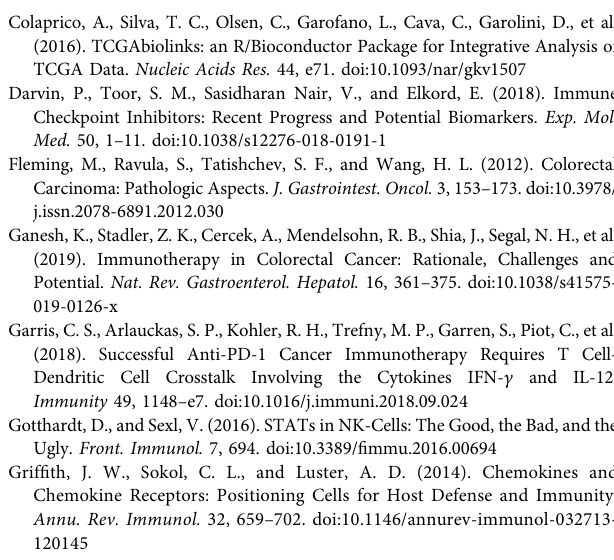
Supplementary Figure S1 | Results of the computation/exclusivity analysis of the top20mutatedgenesintheICI-treatedcohort(Samsteinetal.,2019)(A)andTCGA- COAD (B) cohort. Supplementary Table S1| ResultsofConnectivity Map analysisofthe500highest and lowest regulated differentially expressed genes in the TCGA-COAD cohort. Supplementary Table S2 | The genes in chemokine